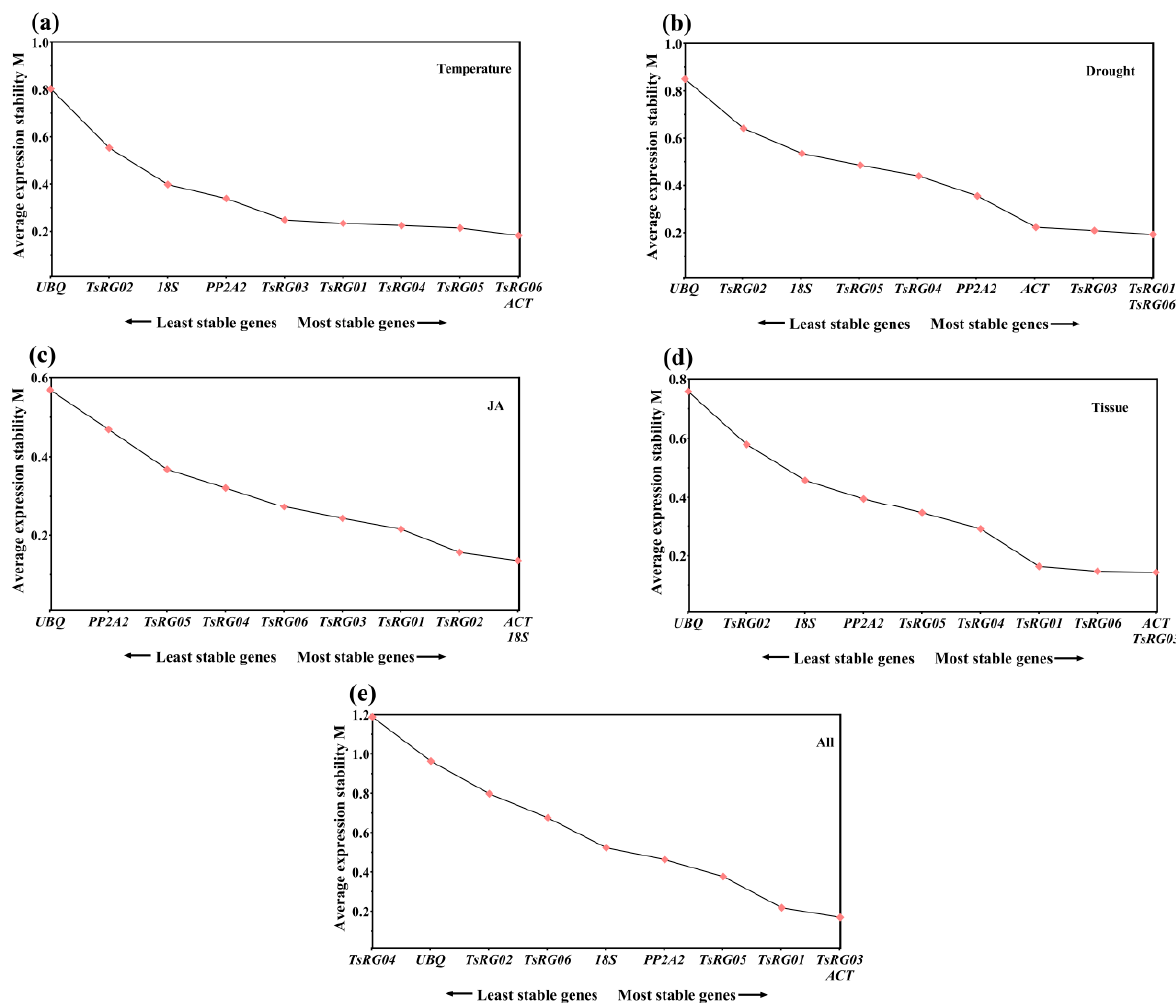
Figure 2. Average expression stability values (M) of 10 candidate RGs under different conditions by geNorm analysis. The direction of the arrows indicates the most and least stable RGs. ( a ) temperature treatments, ( b ) drought treatments, ( c ) JA treatments, ( d ) different tissues, ( e ) all samples.